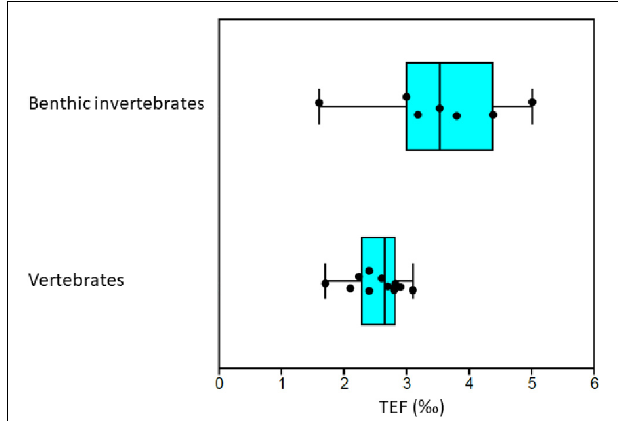
FIGURE 7 | Comparison of trophic enrichment factors (TEF) from published experiments and field studies with known diet for benthic invertebrates and vertebrates (mammals, fish, and birds) that are present in the Barents Sea at least at the genus level. Each black point represent an estimated TEF value. Vertical line in boxes show median and boxes show 25–75% quartiles and whiskers show minimal and maximal values. Supplementary Table 7 gives details on literature